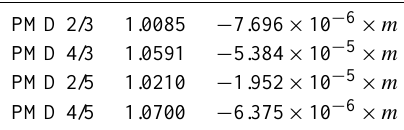
Table 2. Linear fit description of the various relative PMD degra- dation, with m the modified Julian date